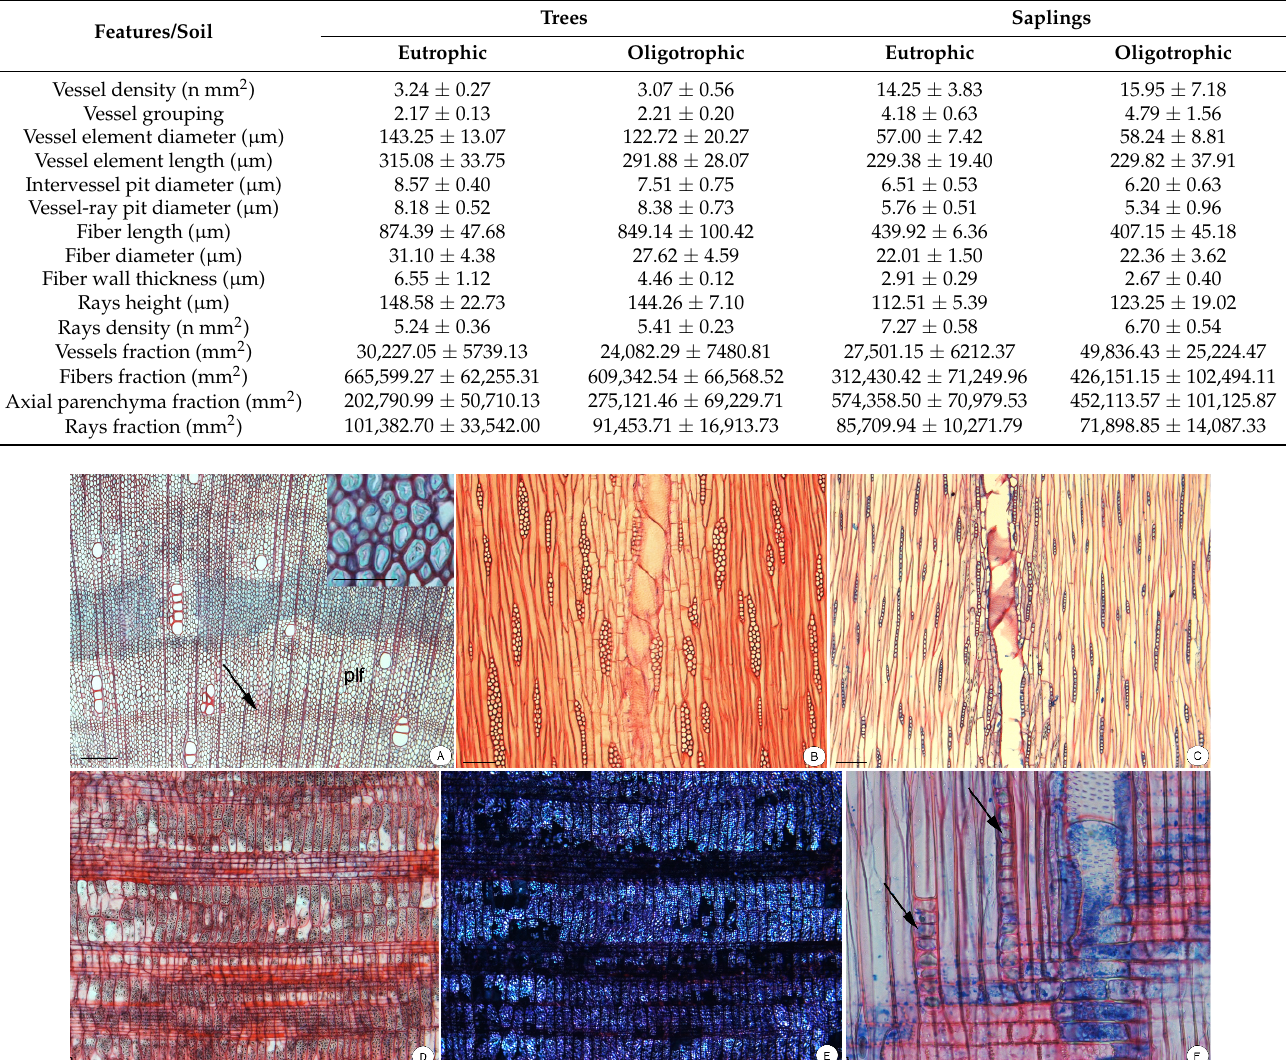
Table 3. Wood anatomy of Enterolobium contortisiliquum 9-year-old trees and 2-year-old saplings growing under different soil conditions. Values are reported as mean ± standard deviation.